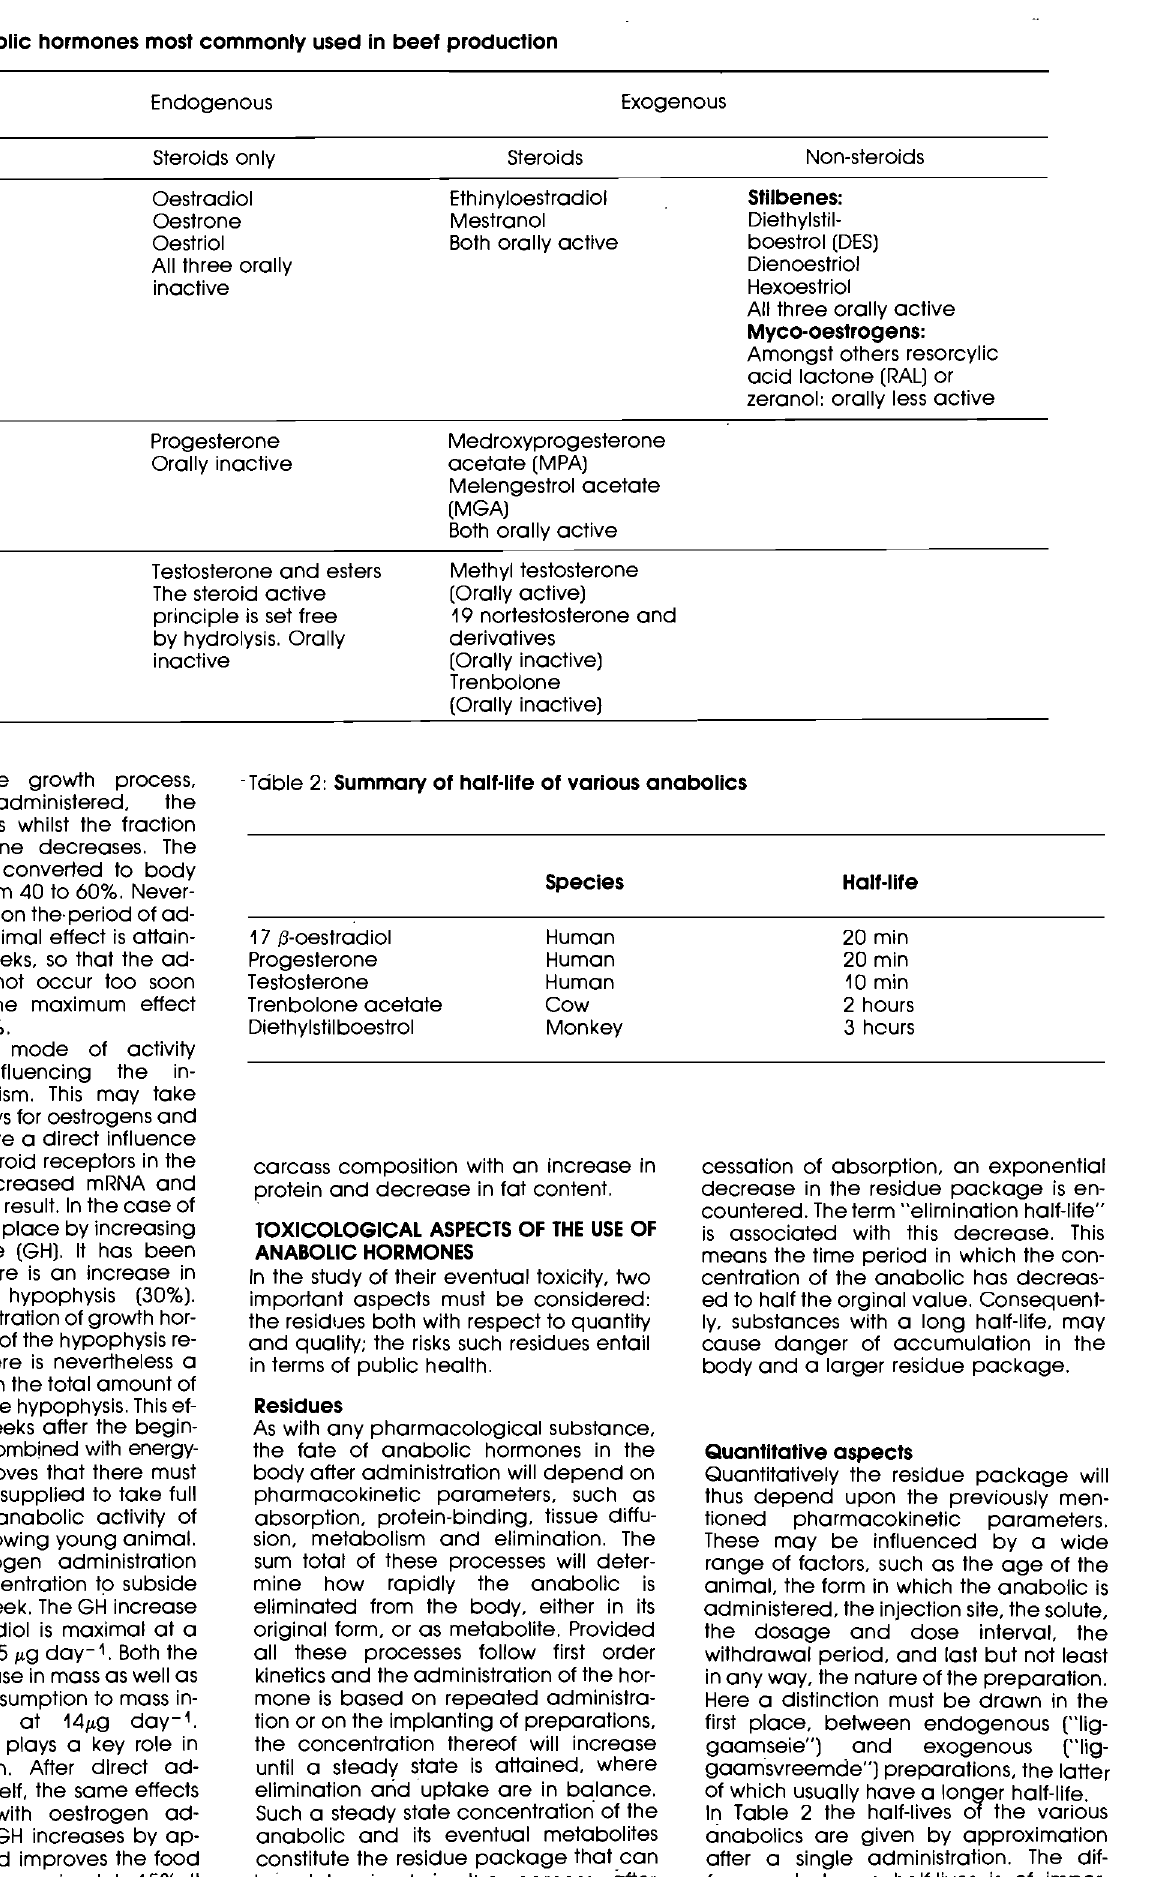
Table 1: Anabolic hormones most commonly used in beef production